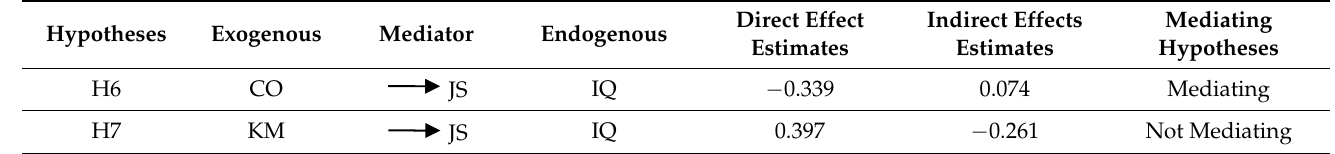
Table 6. Results mediating the hypotheses.